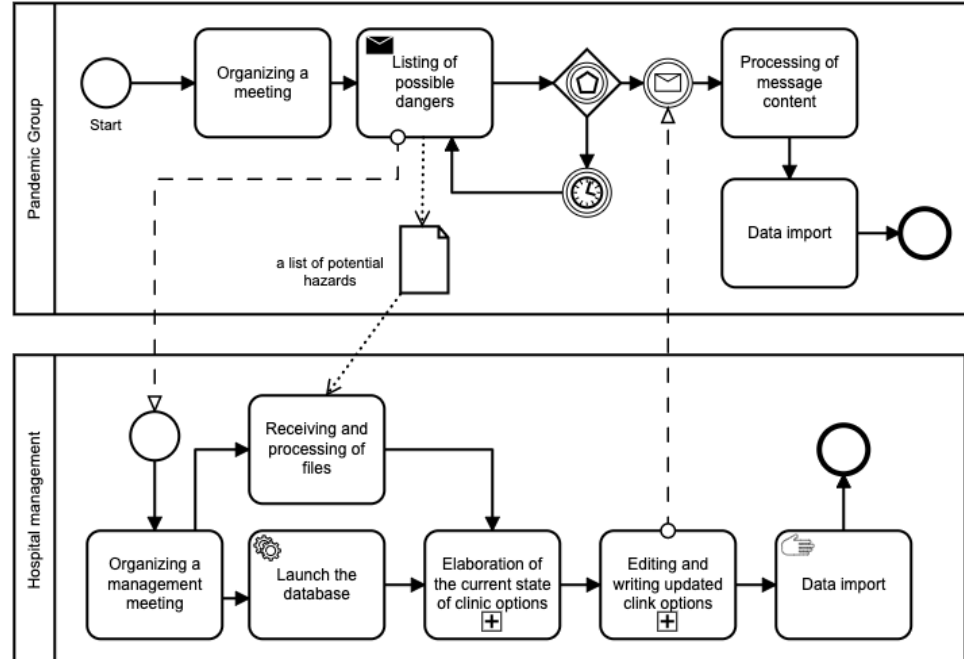
Figure 8. Clinic function